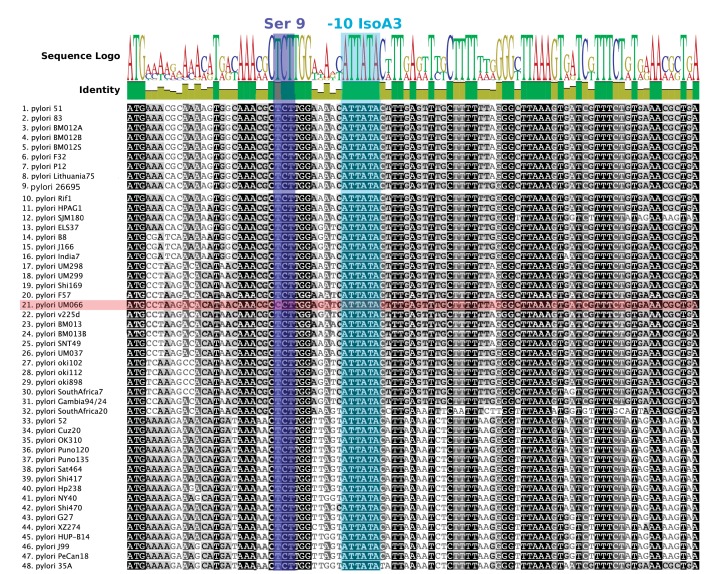
Nucleotide alignment of AapA3 coding region of 49 Helicobacter pylori strains.Conserved nucleotides are highlighted in different tones of gray depending on their conservation level. Sequence logo and identity scores are shown on the top. The highly conserved region corresponding to the second SD sequestering-sequence (serine residue at position 9) and the IsoA3 −10 box are highlighted in dark and light blue, respectively. The UM066 strain, the only strain containing a CCT Proline codon at position 9, is highlighted in pink. Geneious software 8.1.8 (Kearse et al., 2012) was used for sequence collection and alignment.